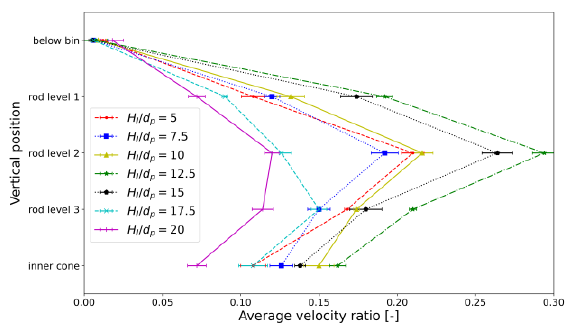
Fig. 7. Average velocity ratio for different level distances order to do not block significantly the particle